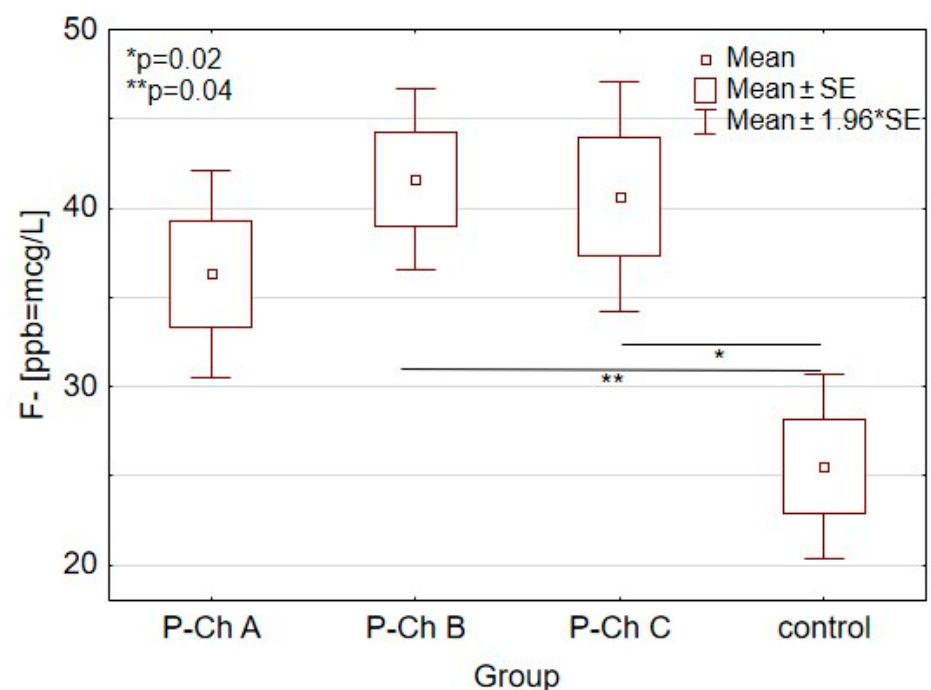
Figure 1. Serum fluoride concentrations in patients with Alcoholic Liver Cirrhosis. *: p = 0.02, **: p = 0.04. Table 4. Correlation between serum fluoride concentration and total bilirubin, MCV, ALT.